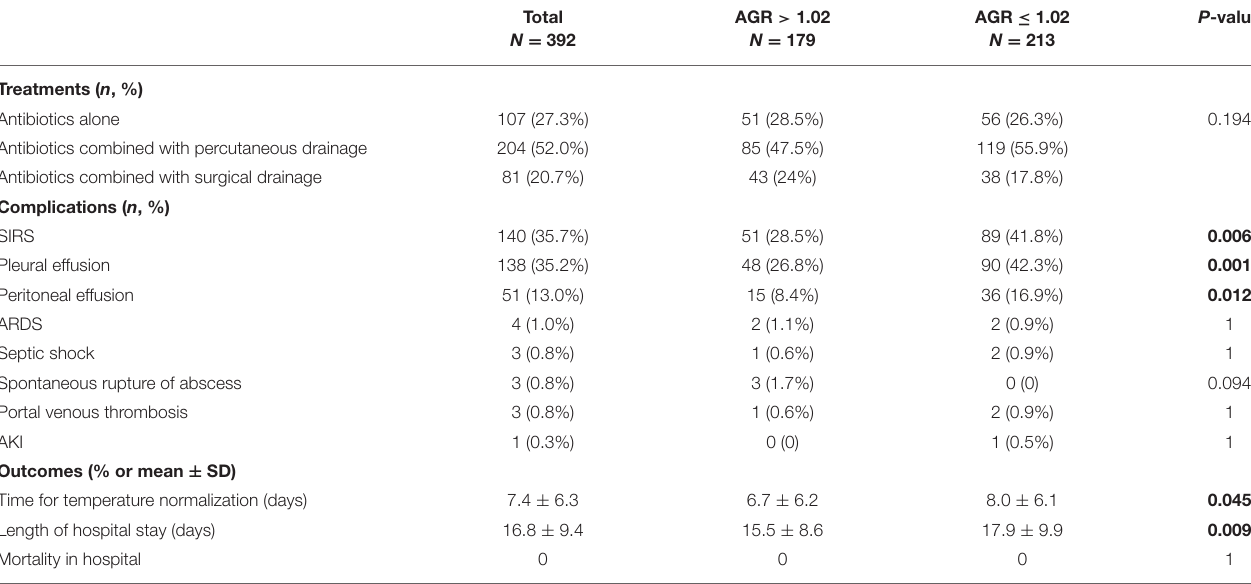
TABLE 4 | Treatments, complications, and